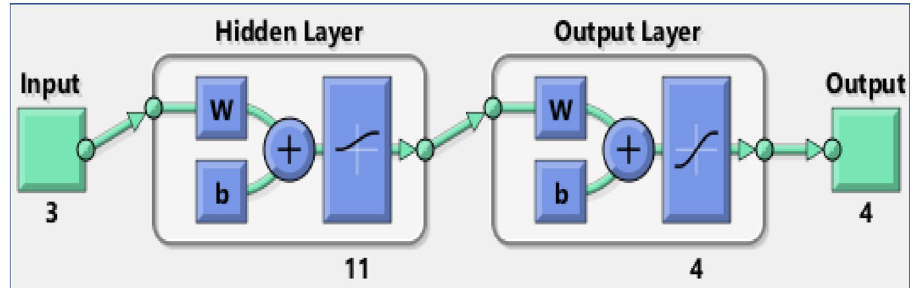
Figure 3. The experimental structure of MLP model.